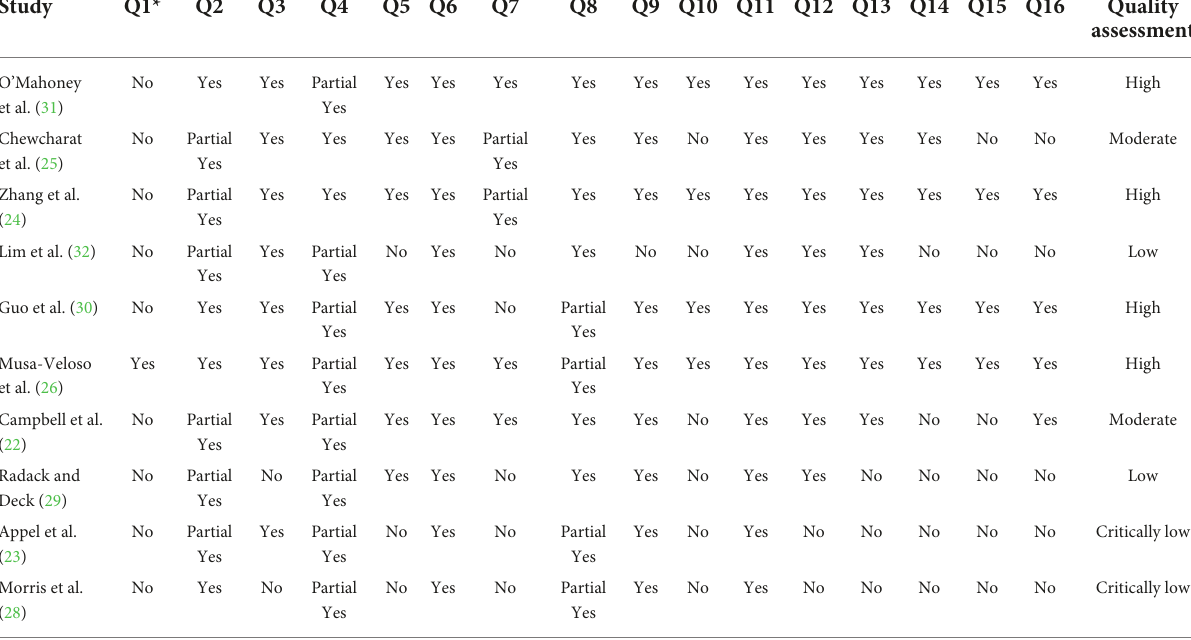
TABLE 2 Assessments of the methodological quality of included studies using the AMSTAR2